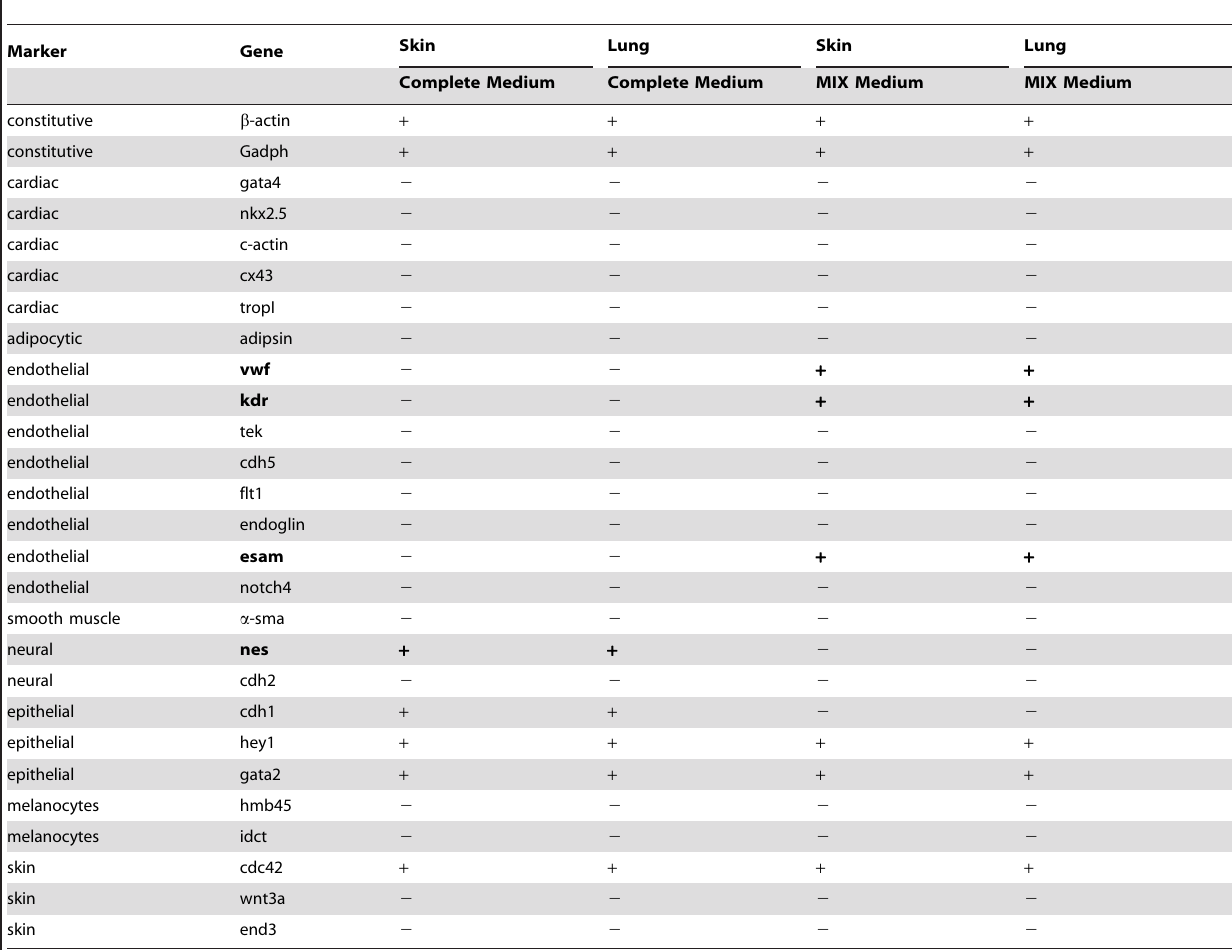
Table 4. Changes on lineage marker expression of MPCs cultured for 7 days in epithelial differentiation medium (MIX medium) compared with growth complete